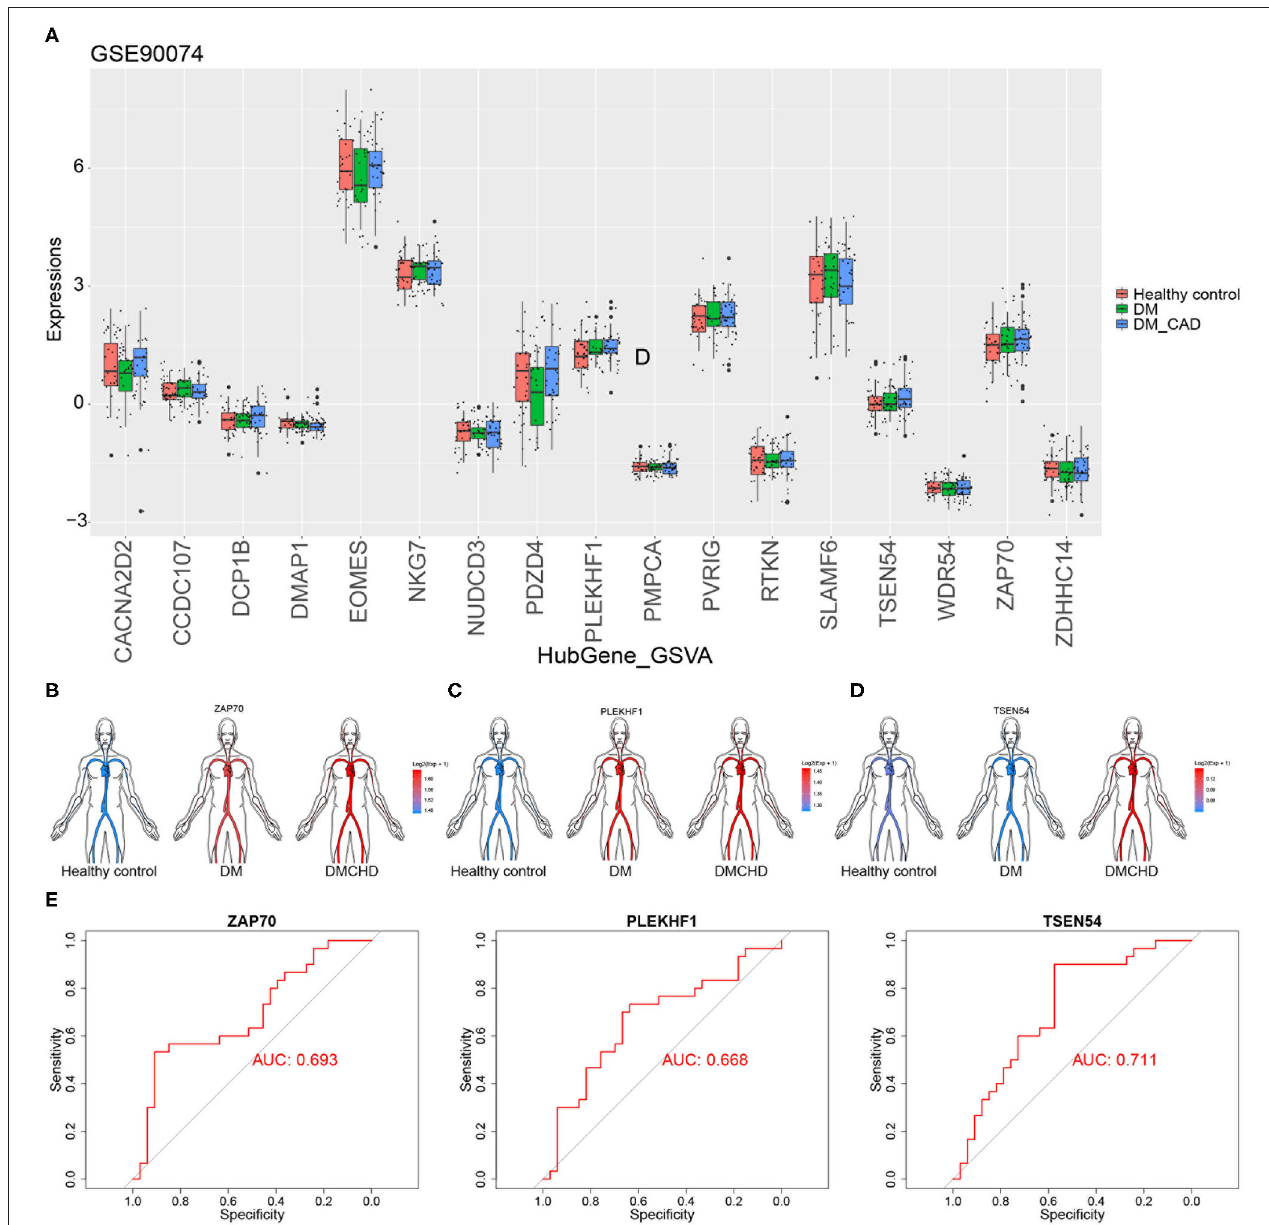
FIGURE 5 | Validation of diabetes mellitus-related atherogenesis genes (DRAGs). (A) The expression of DRAGs in tissue samples from healthy controls or patients with diabetes mellitus (DM) or both diabetes mellitus and coronary heart disease (DMCHD) in a validation data set (GSE90074). Expression levels in GSE34198 of